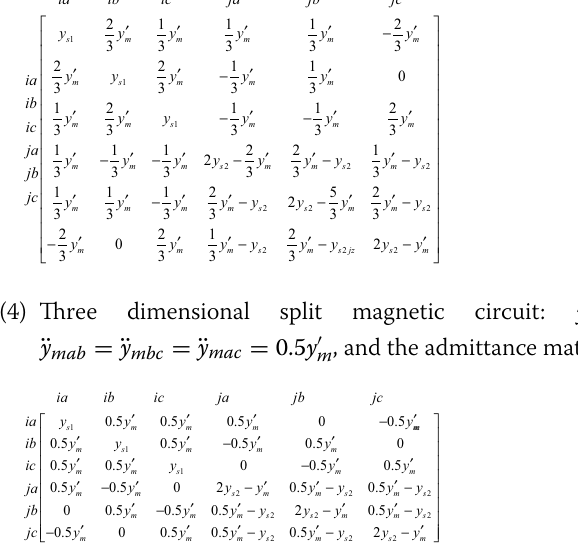
dimensional split magnetic circuit: ˙ y mab = ˙ y mbc = ˙ y mac = 0.5 y ¨ y mab = ¨ y mbc = ¨ y mac = 0.5 y ′ m , and the admittance matrix can be given by